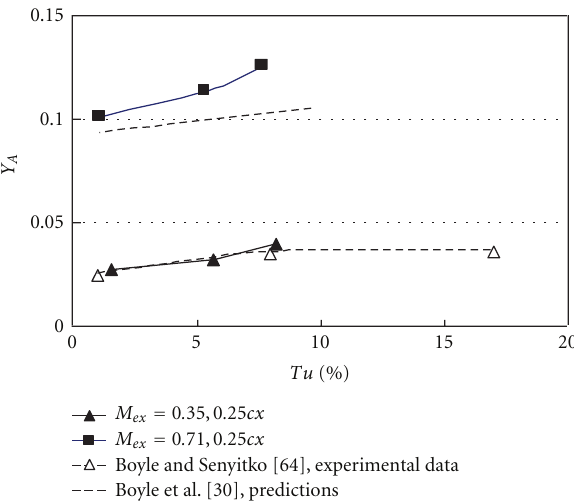
Figure 20: Comparison of area-averaged loss coe ffi cients with values from Boyle and Senyitko [64], and Boyle et al. [30], for smooth, cambered vanes